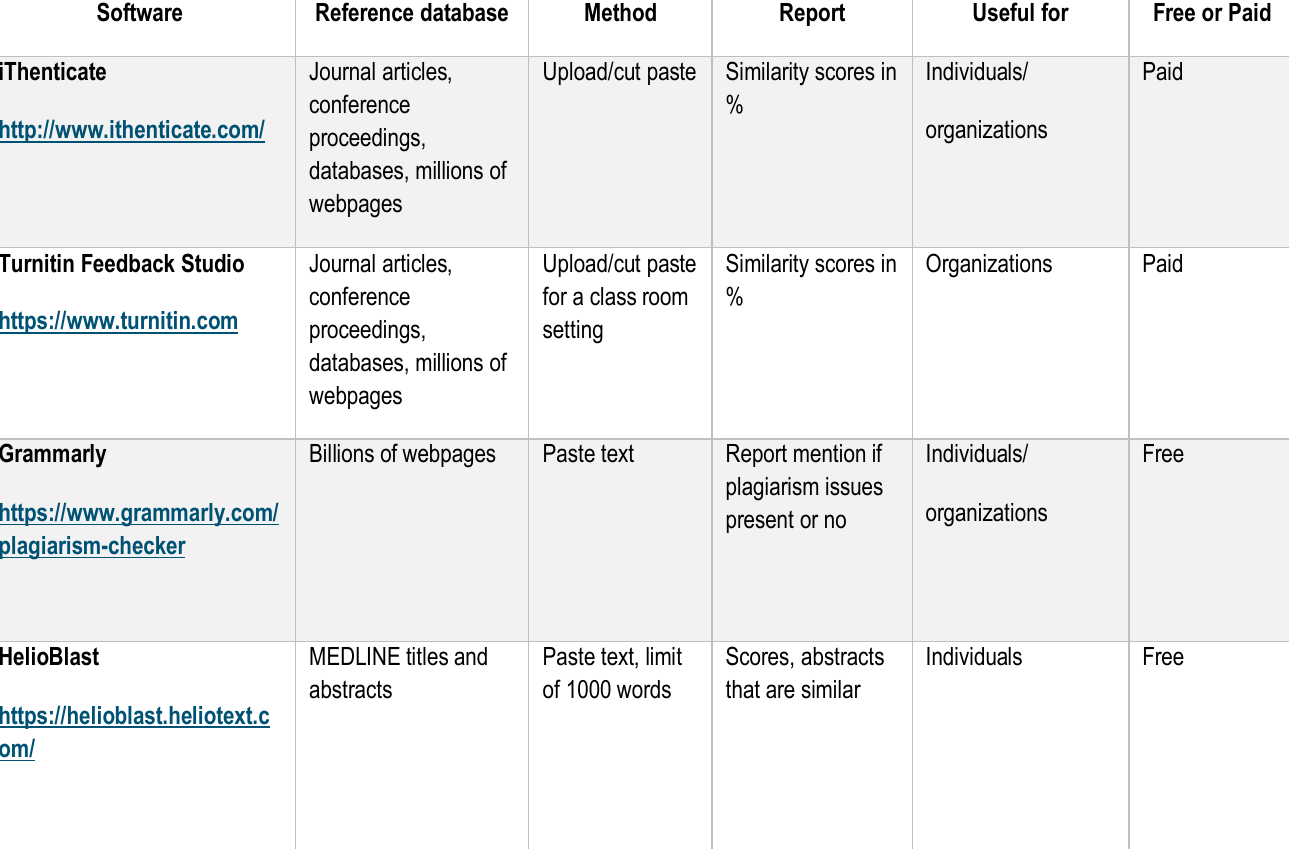
Table 2: Examples of software for detecting